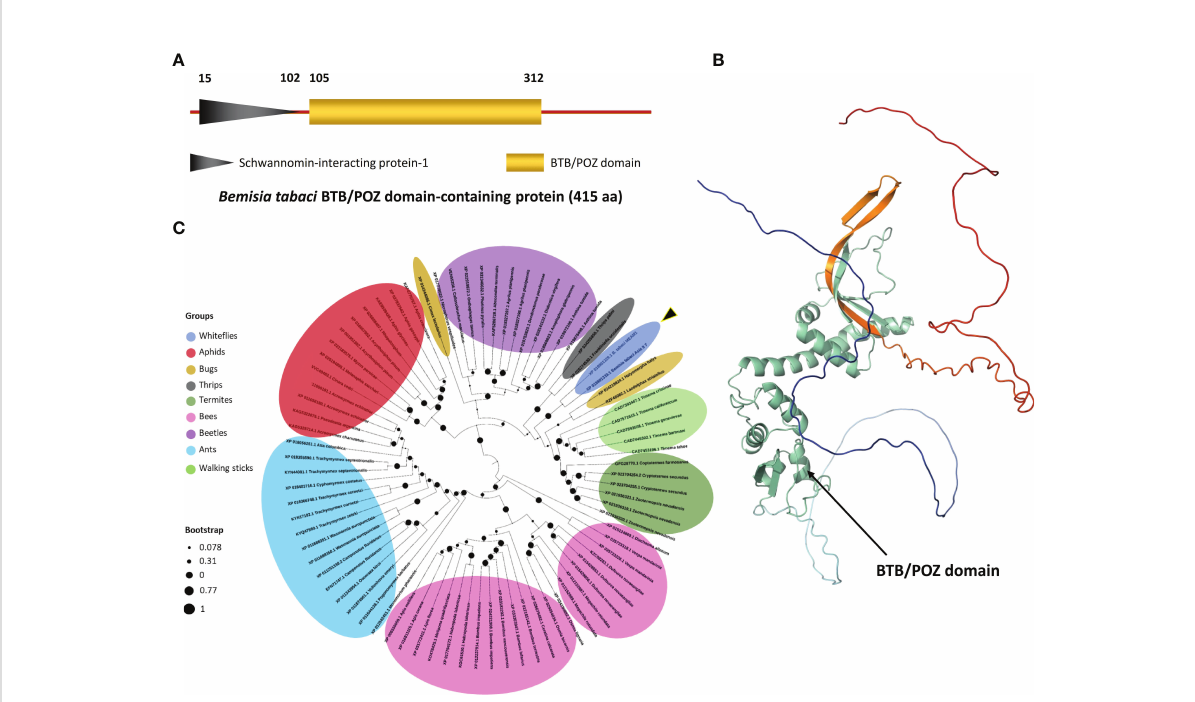
FIGURE 3 Protein (BTB/POZ) structure and phylogenetic analysis. (A) A graphical presentation depicting the type, length and position of the conserved domains as predicted by domain database (CDD) tool available online at NCBI database (https://www.ncbi.nlm.nih.gov/Structure/cdd/wrpsb.cgi). (B) Protein 3D structure was calculated and predicted in ChimeraX software (Pettersen et al., 2021). The BTB/POZ domain is highlighted in cyan- green color. (C) A phylogenetic tree of BTB/POZ and 80 other closely-related proteins was constructed using MEGA X program. Circular black dots represent the bootstrap values deduced from 1000 replicates. BTB/POZ domain-containing proteins belonging to different insect groups are represented by different